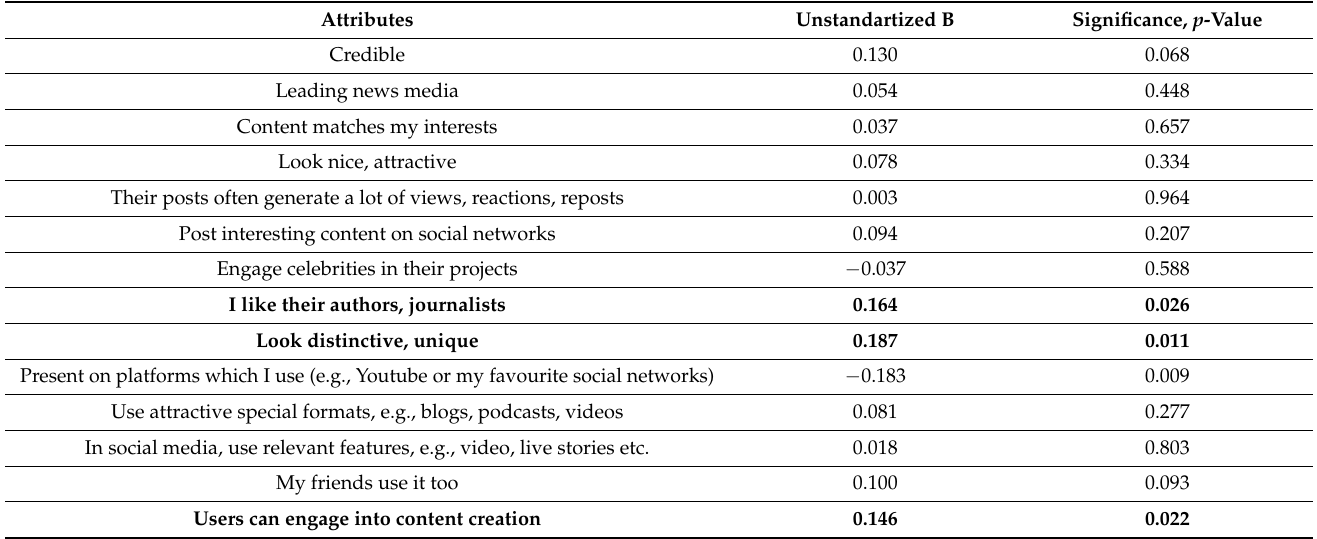
Table A1. Delfi.lv brand uniqueness regression model and brand attribute importance, Coefficients